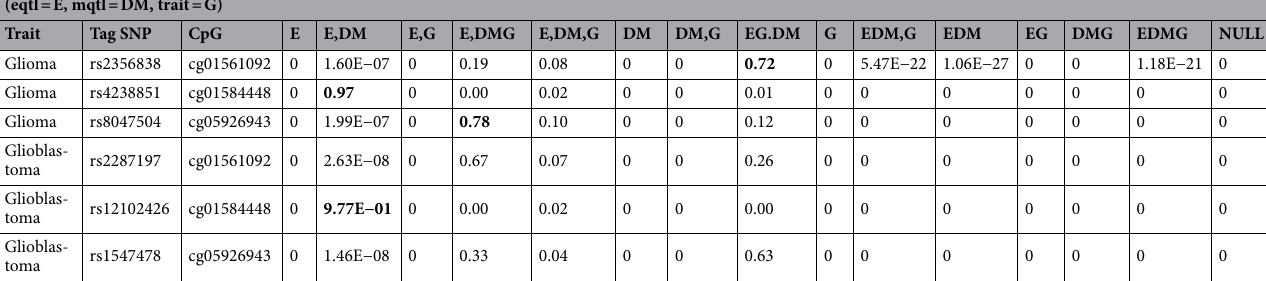
Table 6. The results from the moloc analysis. Significant values are in bold. The columns provide the posterior probability (PPA) for each colocalization scenario where E = eQTL, DM = mQTL, G = trait. The trait is provided in the first column. A PPA > 0.7 was used as suggestive evidence for that scenario and PPA > 0.8 was used as strong evidence.